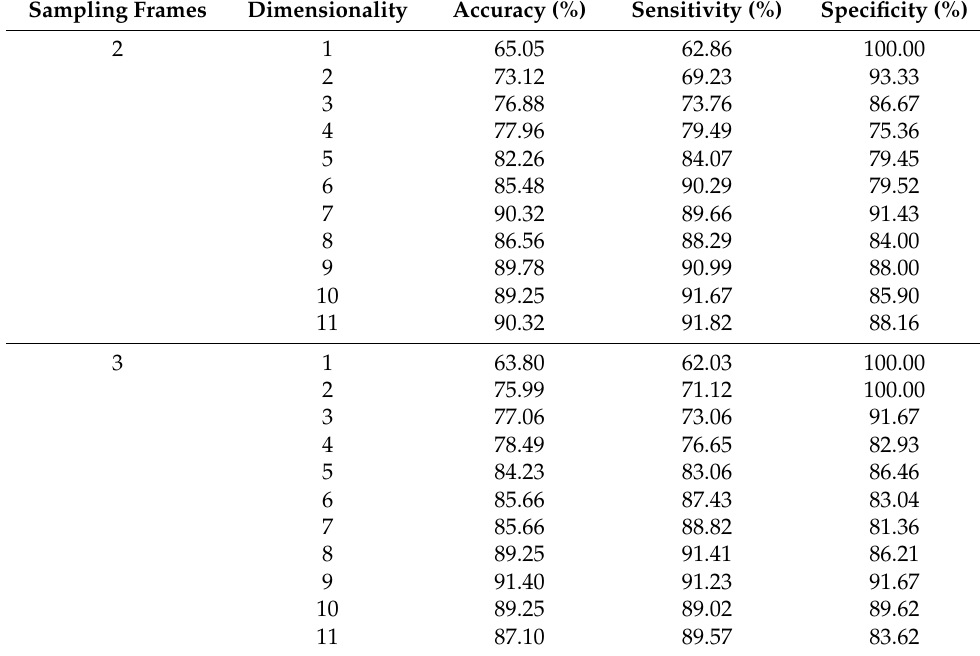
Table 1. Classification accuracy in nonlinear kernel of polynomial function in SVM a . Sampling